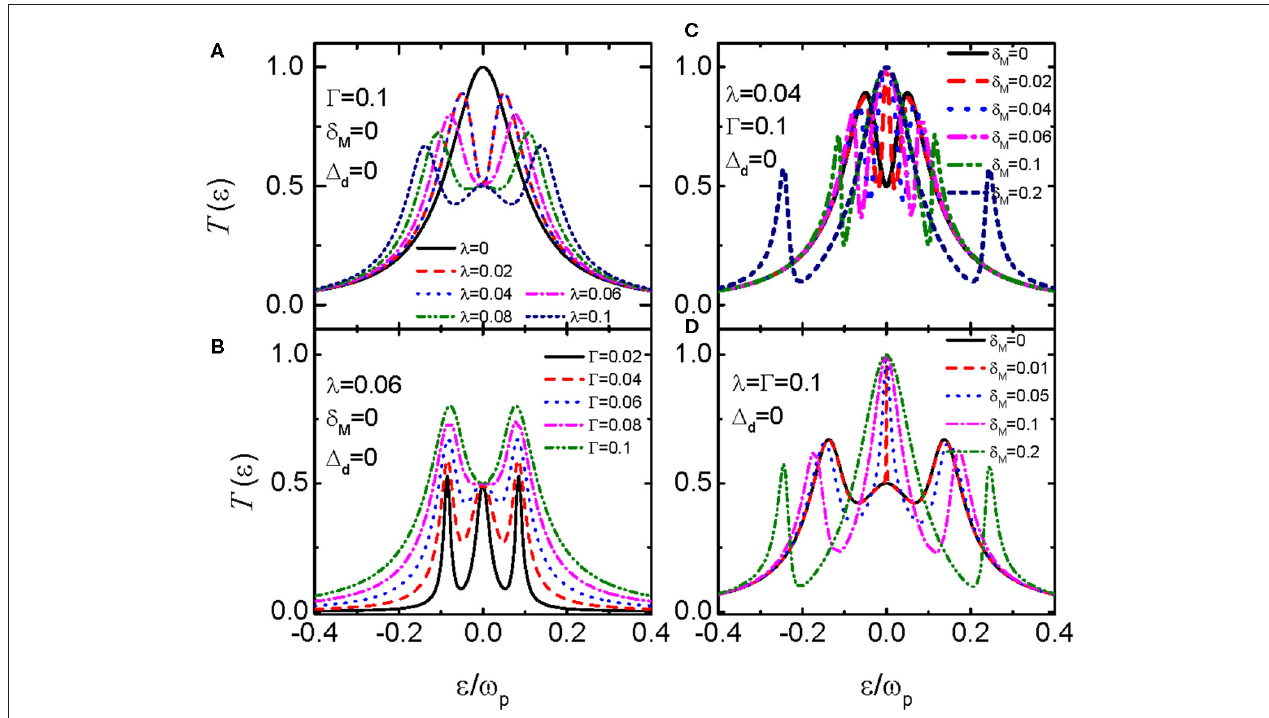
FIGURE 2 | Transmission function T as a function of the electron energy ε in the absence of the photon field 1 d parameters, which are given in the